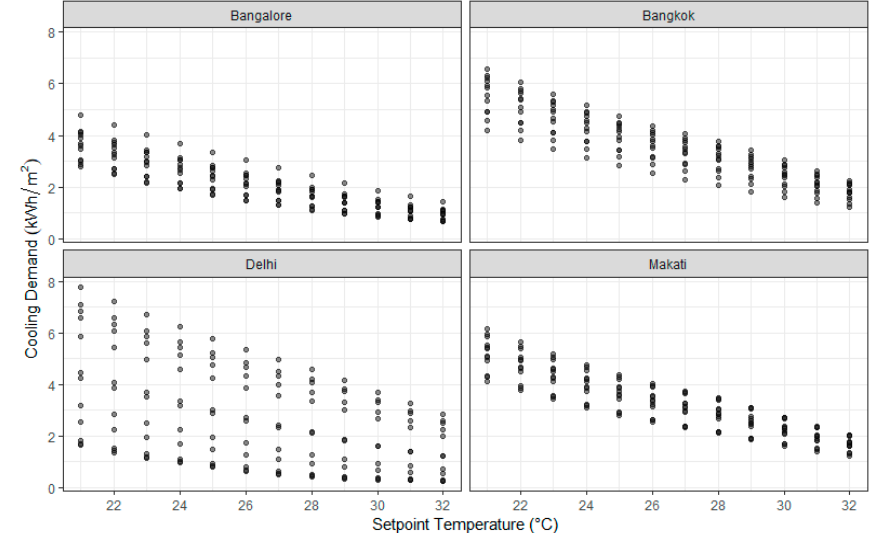
Figure 6. Cooling energy demand at site across a range of building setpoint temperatures for Bangalore, Bangkok, Delhi, and Makati across the x-axis. Each dot in translucent grey is the output from a single simulation, hence areas with a greater density of outputs appear darker in colour. The spread of points for a given setpoint temperature on the y-axis represents the cooling energy demand associated with varying monthly mean external temperature conditions in each location.